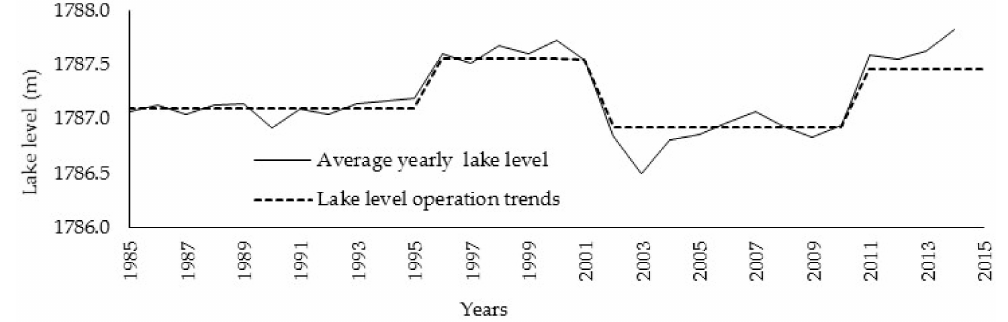
Figure 10. Mean annual Lake Tana level since 1985 (data source: Ministry of Water, Irrigation and Energy, Ethiopia).